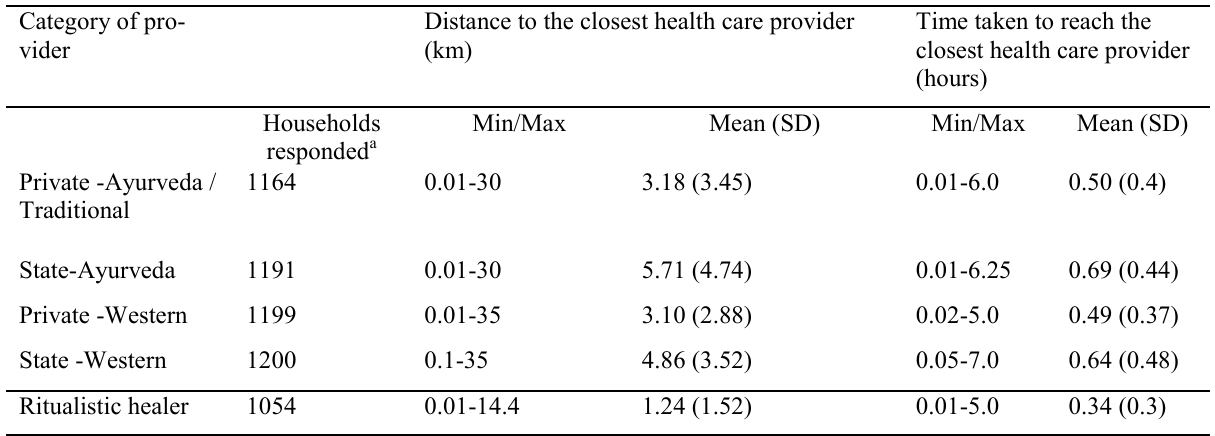
Table 1. Distance and time taken to reach the closest health care provider of each category from the households (n=1200